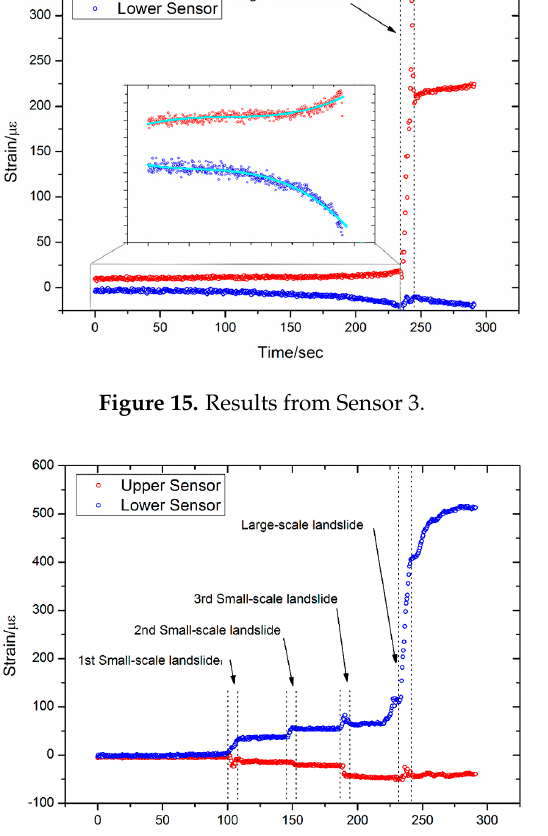
Figure 16. Results from Sensor 2.